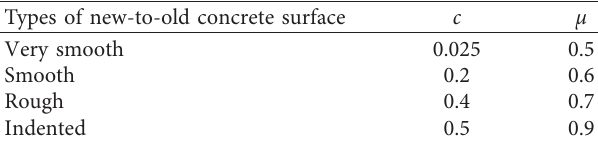
Table 6: Values of c and μ in European